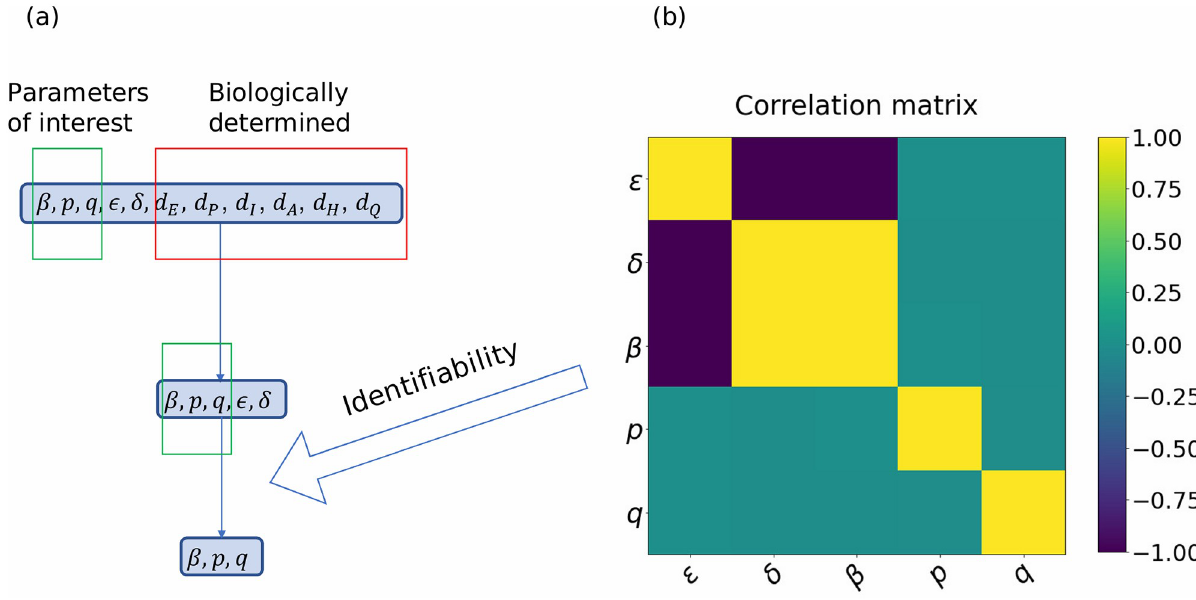
Fig 4. The procedure of choosing parameters to fit. (a) The procedure of determining parameters to fit. We fix d biologically determined, and then fix � , δ due to the result from the correlation matrix analysis. (b) The correlation matrix of five parameters. Each colored off-diagonal cell represents the correlation between two parameters. Green means (almost) not statistically correlated while yellow/purple represents positively/negatively correlated, respectively.